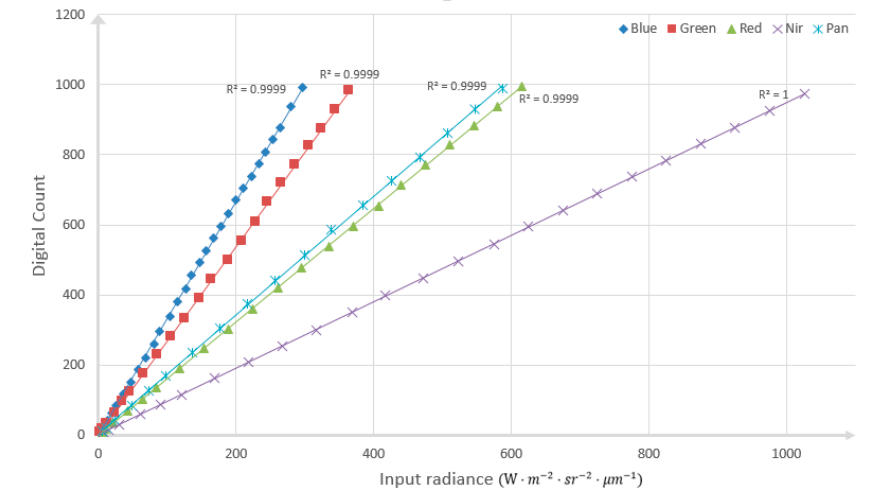
Figure 2. The relationship between input radiance and output DN (Digital Number).